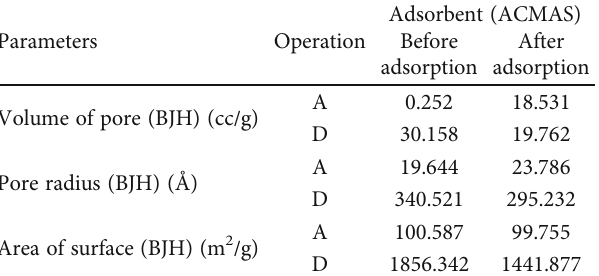
Table 2: BJH analysis